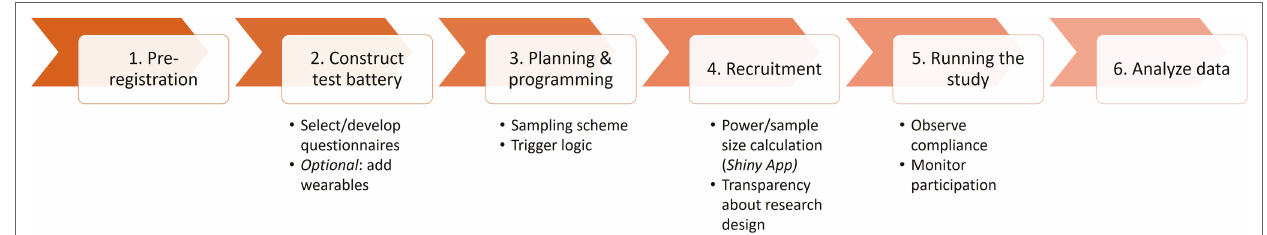
FIGURE 1 | Overview of the steps for planning and running an Experience Sampling Method (ESM)